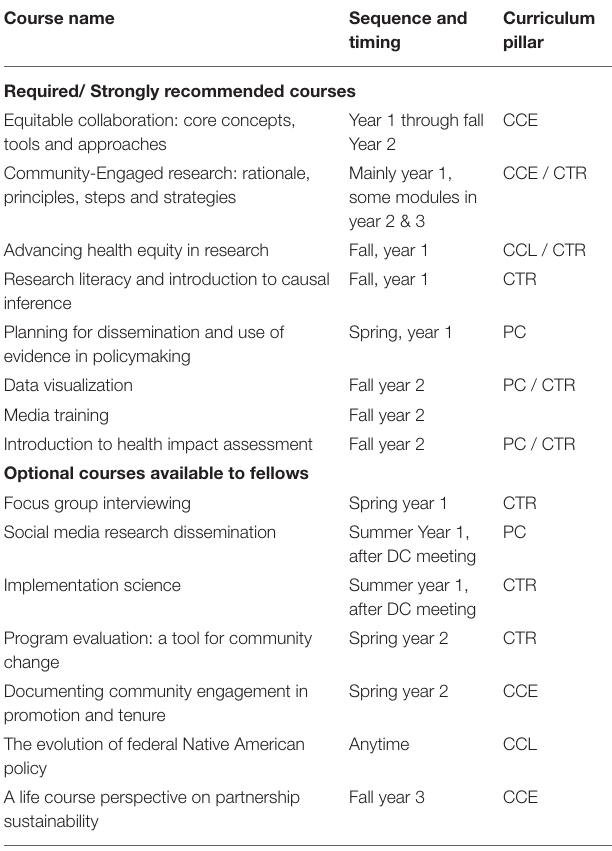
TABLE 3 | Video-Based mini-courses as part of the IRL